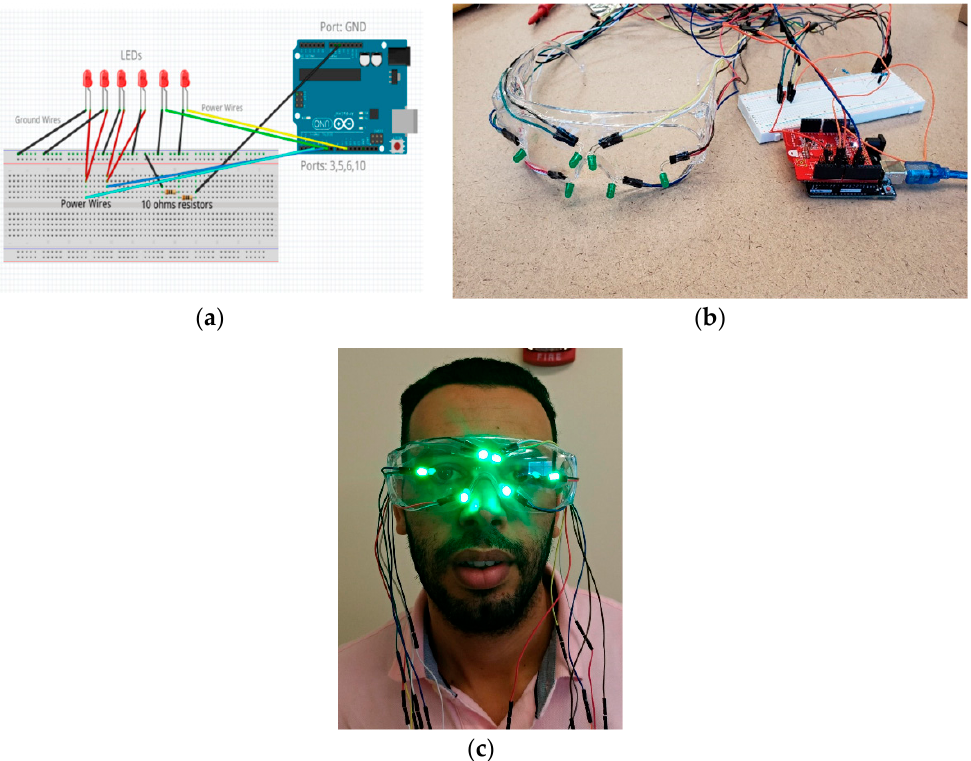
Figure 6. The FacePET wearable device. ( a ) Wiring sketch diagram for FacePET LEDs; ( b ) Goggle with LEDs and BLE microcontroller; ( c ) FacePET wearable prototype worn by a bystander (the person in the photo is one of the authors).